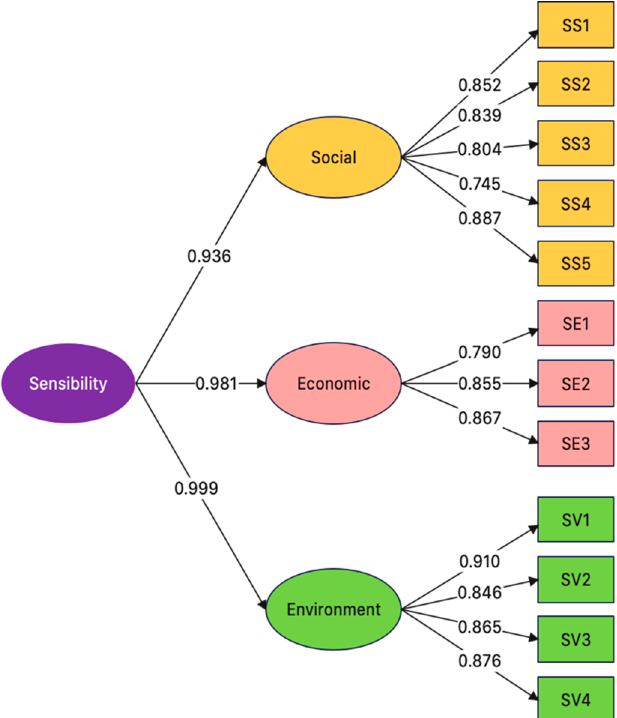
Figure 4. Structural equation model and the factor loadings of UHI sensitivity indicators and dimensions.